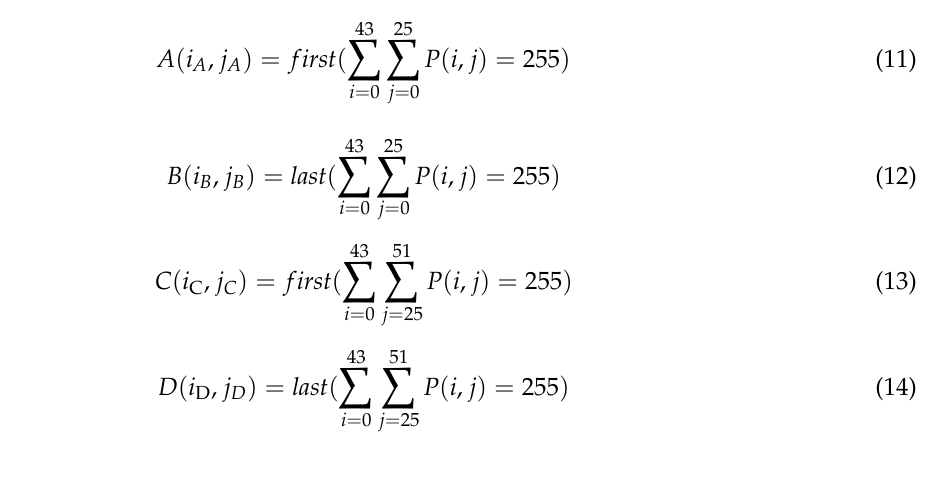
Figure 7. Endpoints of the left and right soles. 2.4. Calculation of Foot Arch Index After the endpoint coordinates are obtained, the length of the foot can be calculated as shown in Equations (15) and (16). 𝛼 1 , 𝛼 2 are the lengths of the left and right feet, respectively. 1